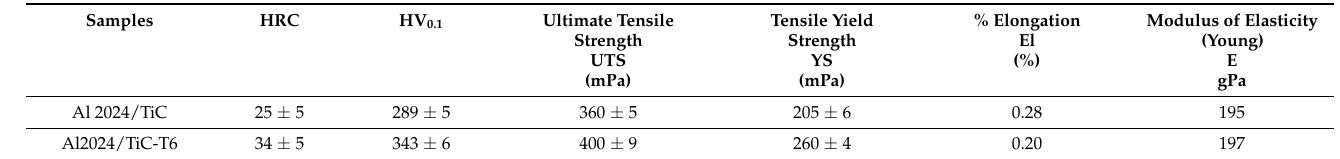
Figure 4. XRD patterns for as-infiltrated and heat-treated composites. Table 2. Effect of T6 heat treatment on the tensile properties and hardness values of the MM and the MMC-Al-2024/TiC, before and after T6 heat